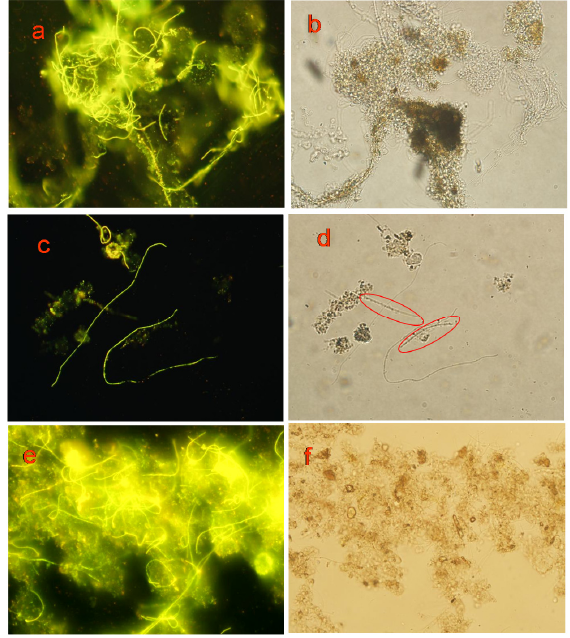
Figure 5. Images of observation under fluorescent light and nature light (400×). The microscope images taken in the labeling of M. parvicella by: probe A ( a , c ); and probe B ( e ) under fluorescent light; and the images under natural light of: probe A( b , d ); and probe B ( f ).